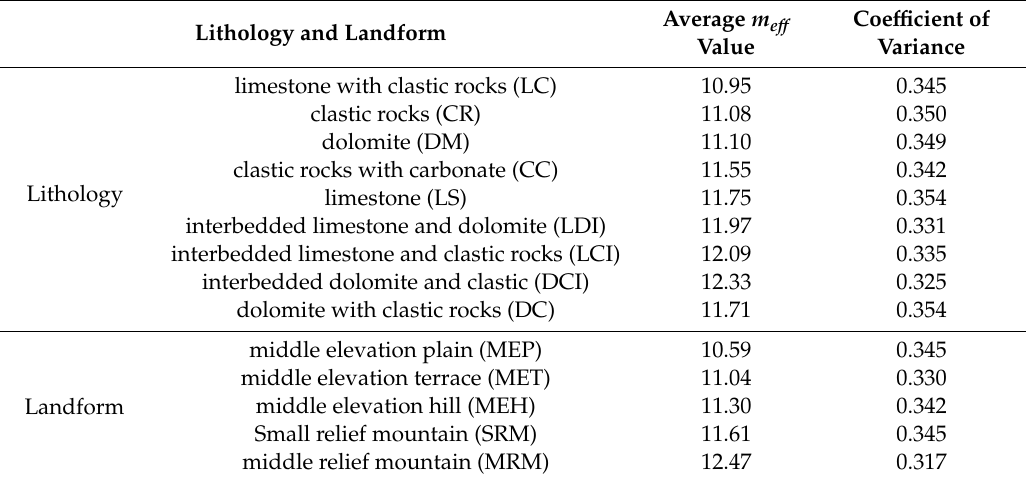
Table 3. Statistical analysis of the index of landscape fragmentation by lithology and landform type.